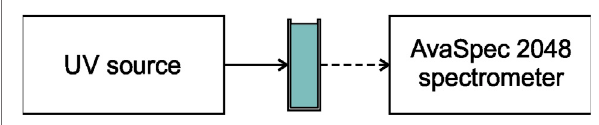
FIGURE 3 | UV transmission spectrum measurements setup.